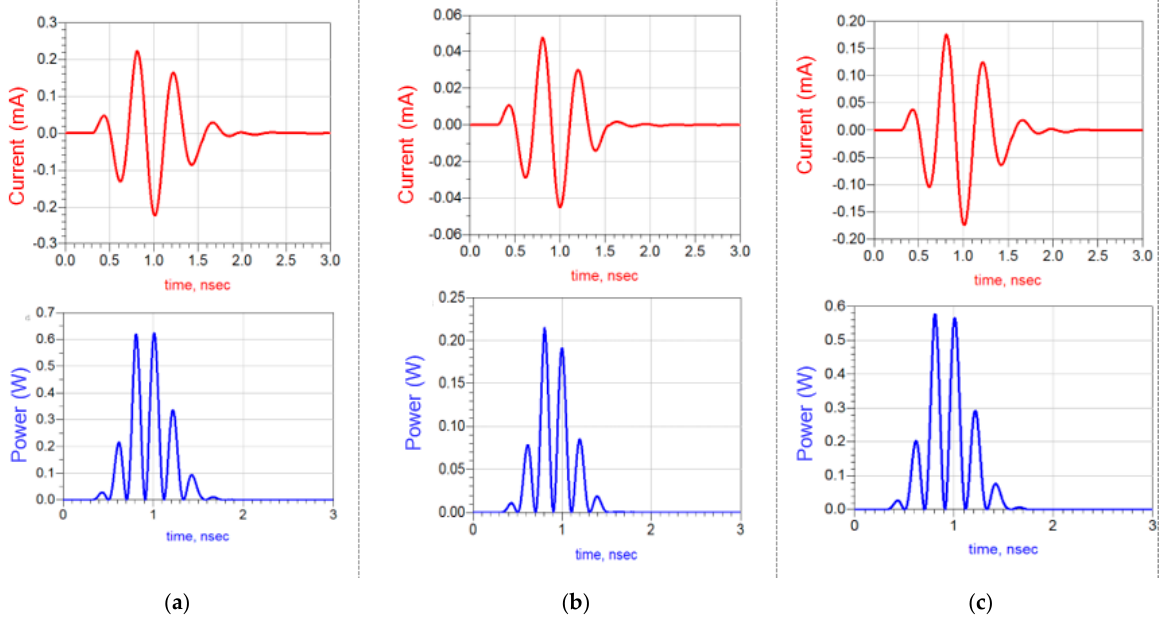
Figure 20 . ( a ) The antenna equivalent circuit’s current and power waveforms connected to a 50 Ohm load; ( b ) current and power of the antenna equivalent circuit connected to a 377 Ohm load; ( c ) current and power of the antenna equivalent circuit connected to 75 Ohm load.